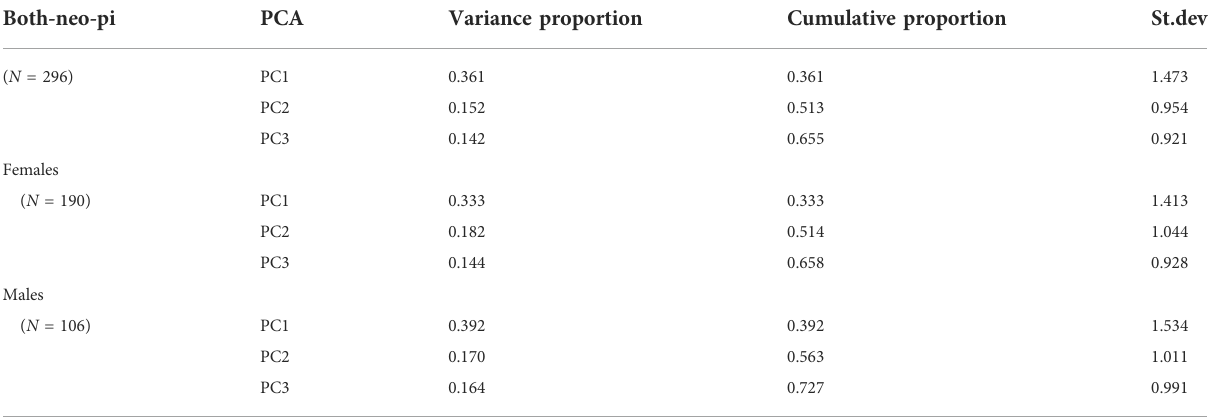
TABLE 3 Alternate principal components analysis replacing the reversed OHQ score with a sum of the depression-endorsing items of the NEO Personality inventory. Both-neo-pi